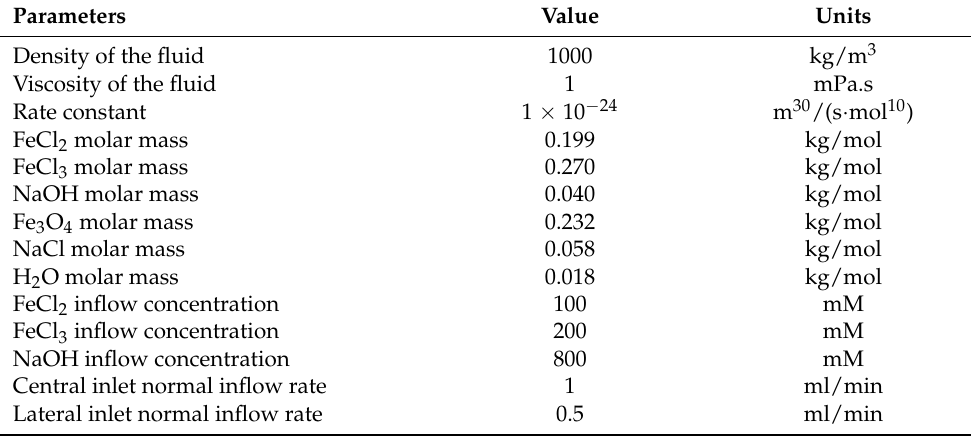
Table 1. Parameters of reaction